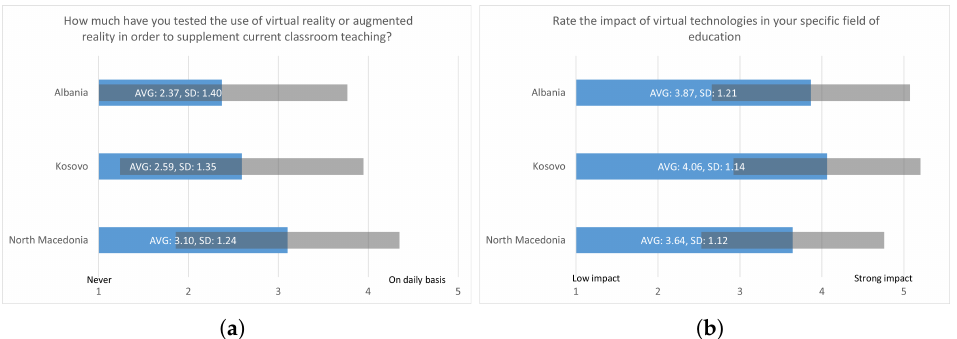
Figure 7. ( a ) Supplementing teaching with AR or VR. ( b ) Impact of virtual technologies in specific field of